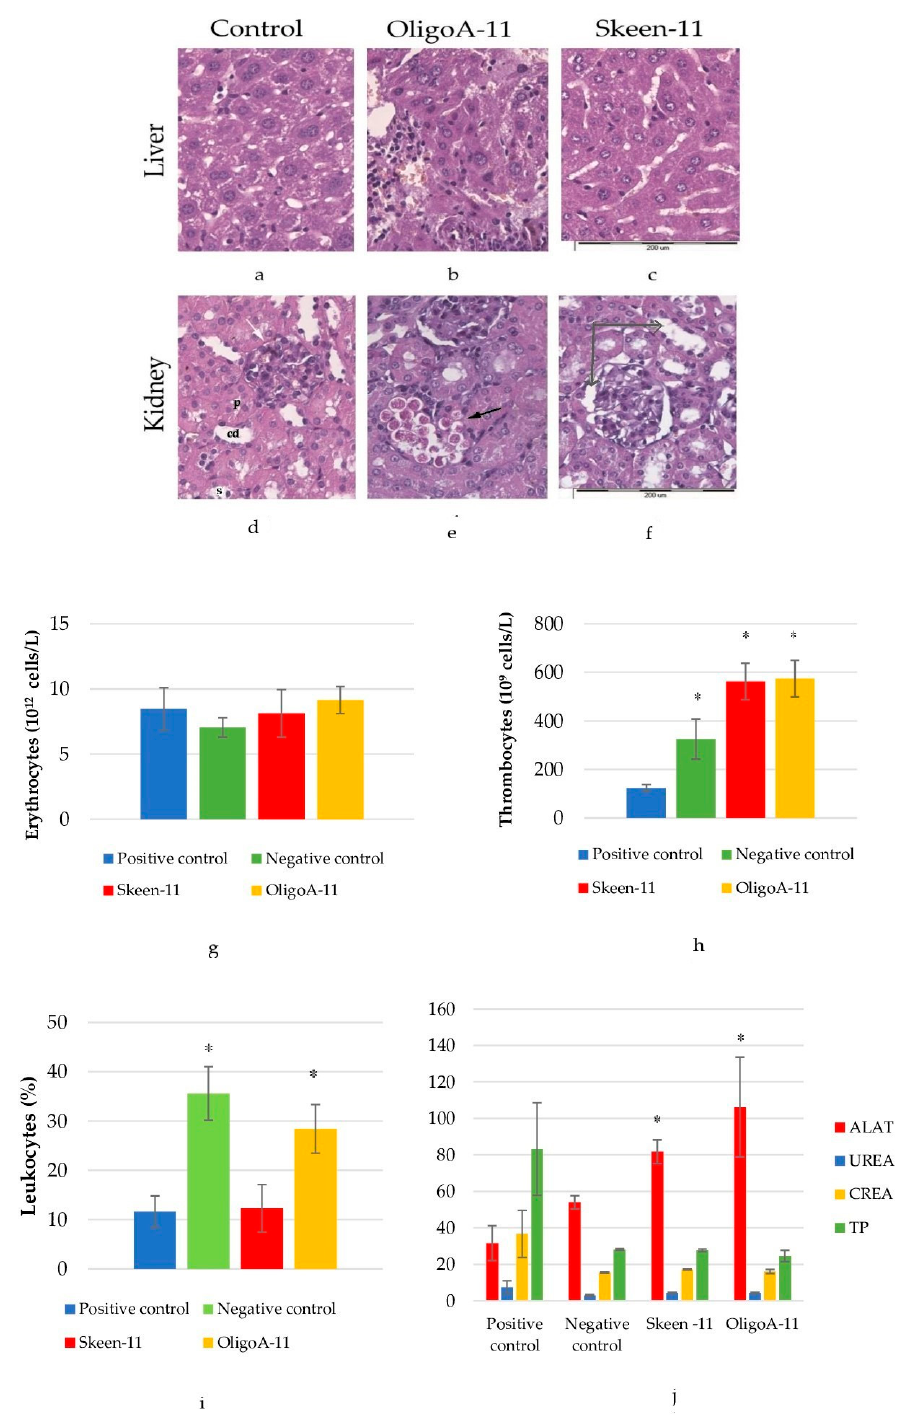
Figure 3. Mouse liver. Hematoxylin-eosin. Approximately 40 × . ( a )—Control group, ( b )—OligoA- 11 group, ( c )—Skeen-11 group; cortex of the kidney. Hematoxylin-eosin. Approximately 40 × ; ( d )—Control group(p—proximal tubule, s—distal tubule, cd—collecting duct); ( e )—OligoA-11 group (black arrow—desquamation of proximal tubule epithelium and accumulation of lymphocytes next to it); ( f )—Skeen-11 group (gray arrow is the dilated urinary space of the renal corpuscle and the lumen of the distal tubule); ( g )—analysis of erythrocytes; ( h )—analysis of thrombocytes; ( i )—analysis of leukocytes; ( j )—biochemical parameters of mice blood after ASO therapy on the 8th day from the start of the experiment (statistics performed compared with negative control); values are shown with the means and SE. A significant difference compared to the control group ( p < 0.05) is marked with